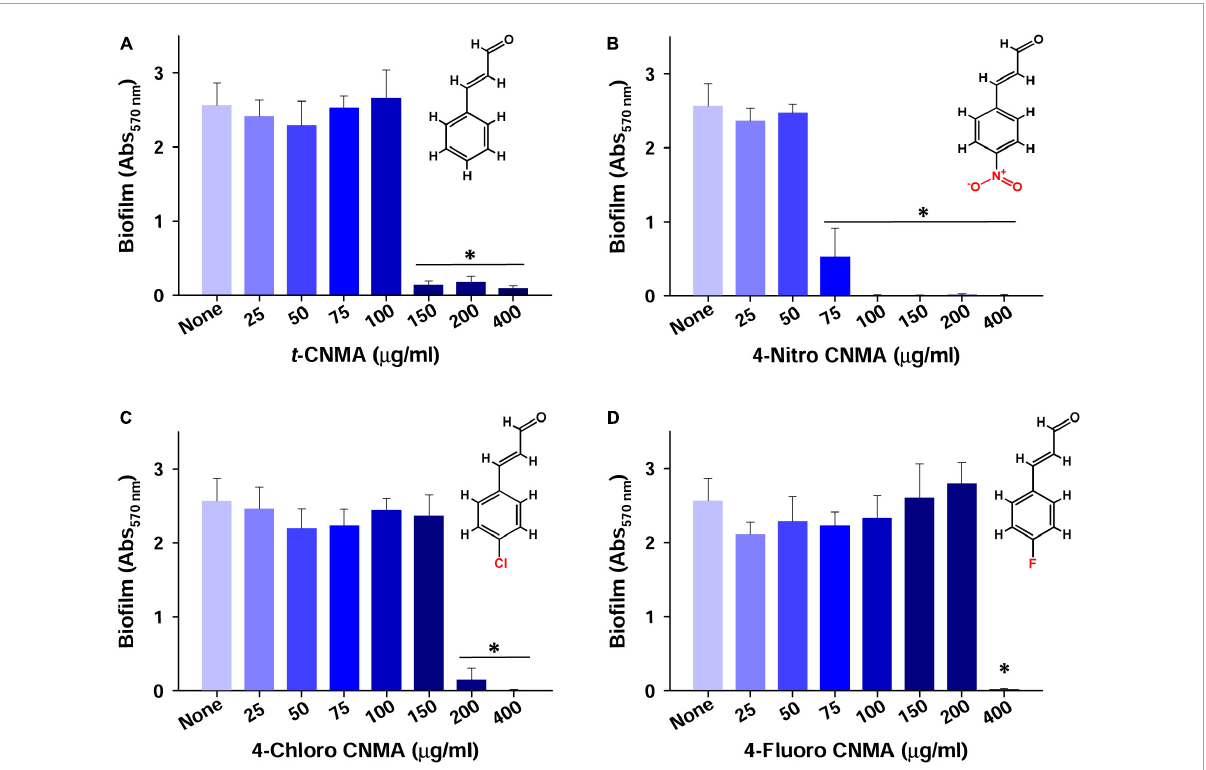
FIGURE1 Inhibition of A. tumefaciens biofilm formation by t -CNMA (A) , 4-nitro CNMA (B) , 4-chloro CNMA (C) , and 4-fluoro CNMA (D) after 48 h in polystyrene microtiter plates containing LB. “ ∗ ” denotes a significant difference by the two-tailed t -test between non-treated and treated